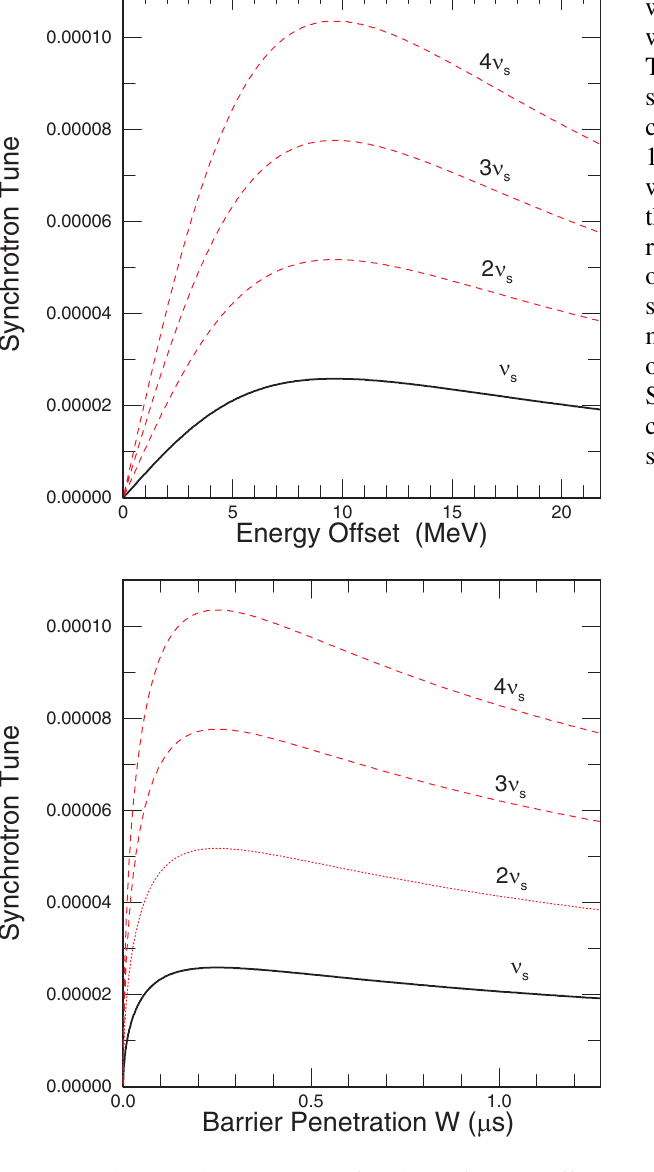
FIG. 13. (Color) Synchrotron tune as functions of energy offset on the left and barrier penetration on the right, when the barrier (cid:1) T (cid:1) 1 : 27 (cid:1) s and separation and barrier width are equal or T 2 1 (cid:1) 2 kV . Also shown in the plots are higher barrier voltage V 0 synchrotron